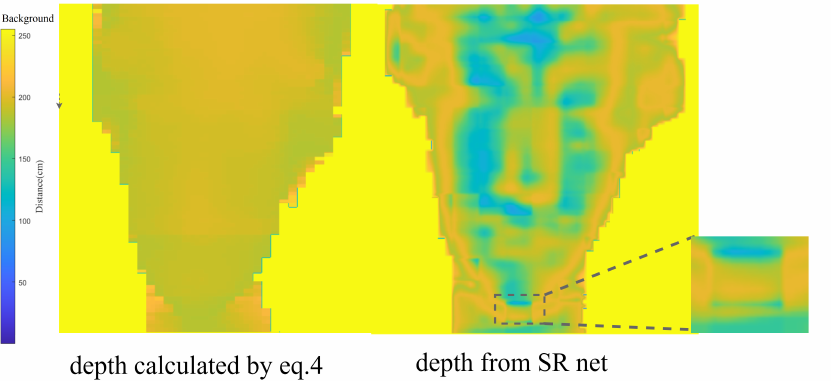
Figure 9. Comparison with maximum likelihood estimation. The “grid effect” generated by the up-sampling neural network is shown as a